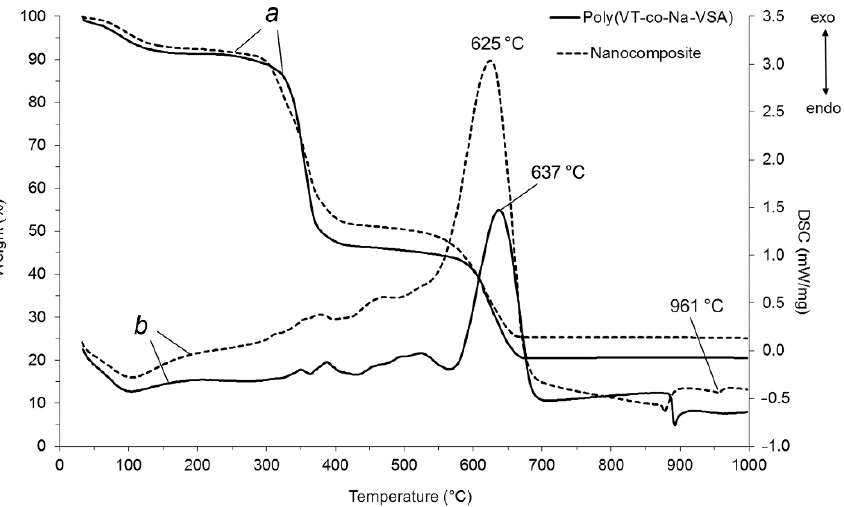
Figure 9. Thermogravimetric ( a ) and differential scanning calorimetry ( b ) curves for the starting poly(VT-co-Na-VSA) and AgNPs nanocomposite.